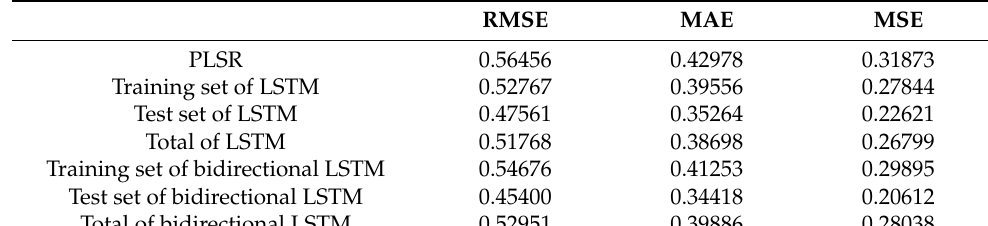
Table 1. Comparison of errors of different models.